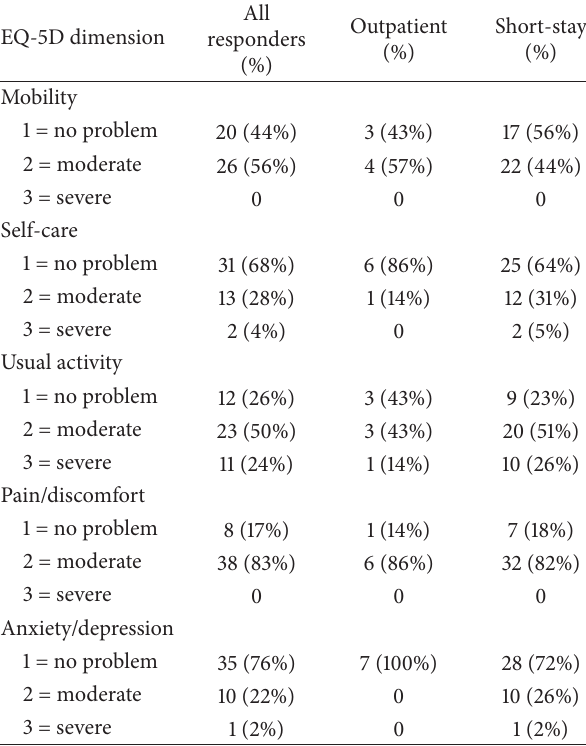
Table 3: EQ-5 patient responses by